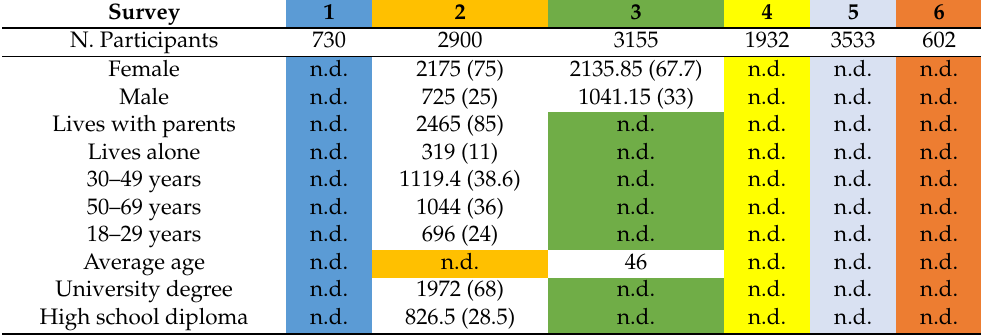
Table 2. Socio-demographic profile of respondents, absolute value (N.) and (%) on the total. Survey